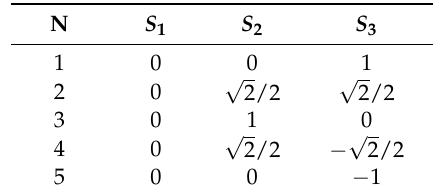
Table 1. Symbols in the Stokes Space.